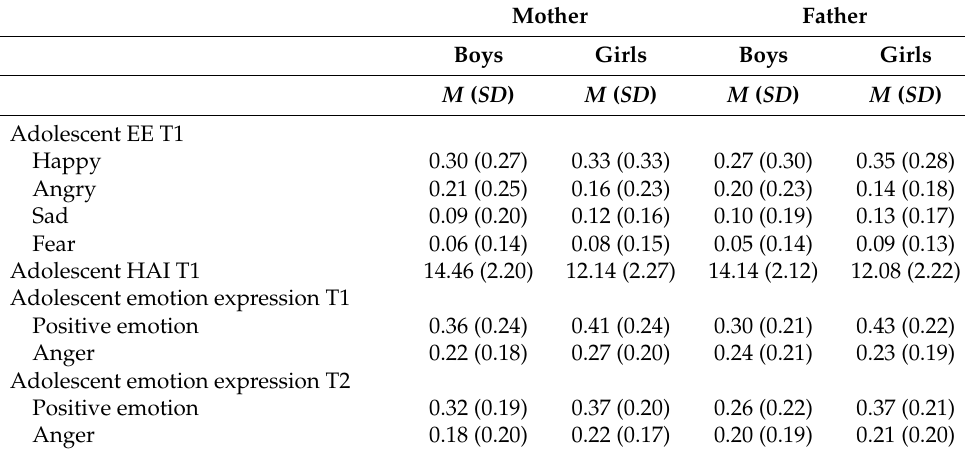
Table 2. Descriptive statistics for adolescent self-reported emotional expectancies, hostile attributions of intent, and observed emotional expressiveness with mother and